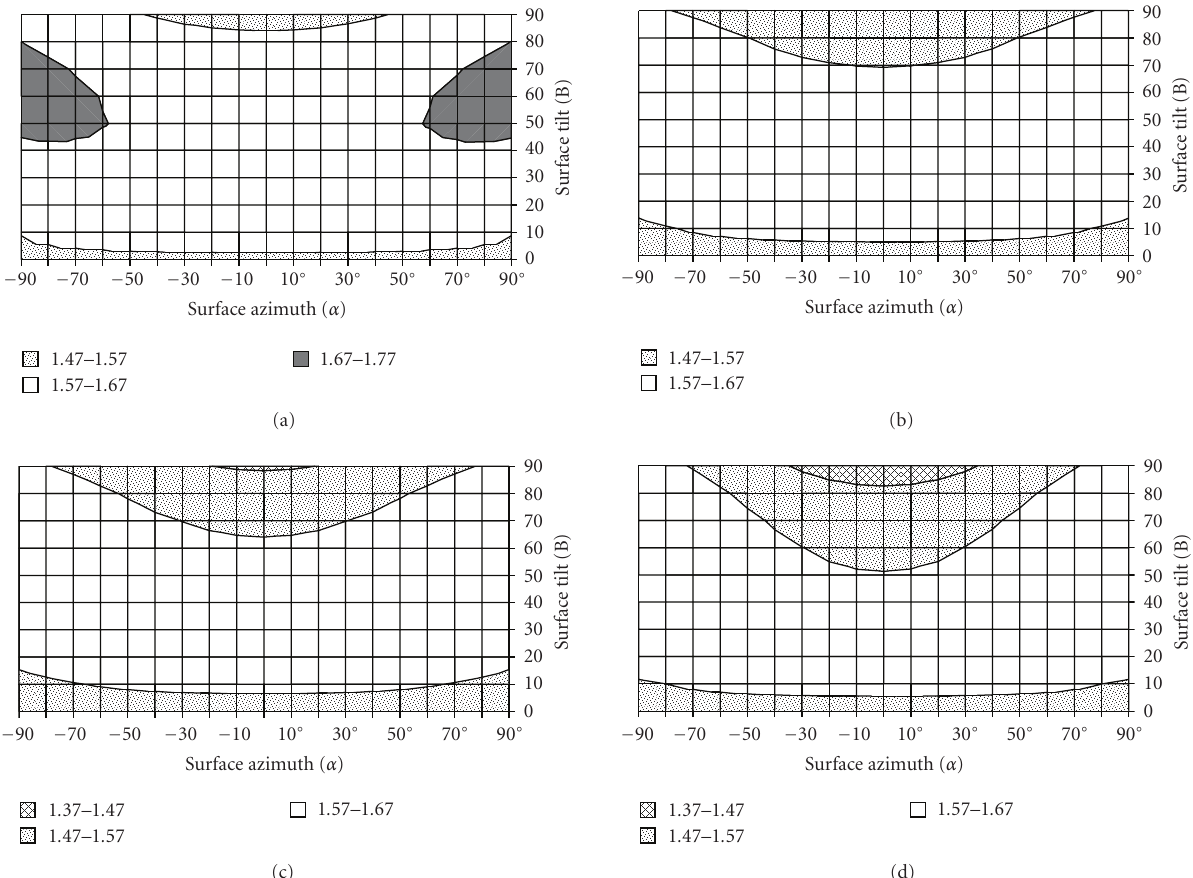
Figure 2: Current factor for di ff erent orientations and European locations. (a) Bergen-Norway, (b) Bonn-Germany, (c) Paris-France, (d)